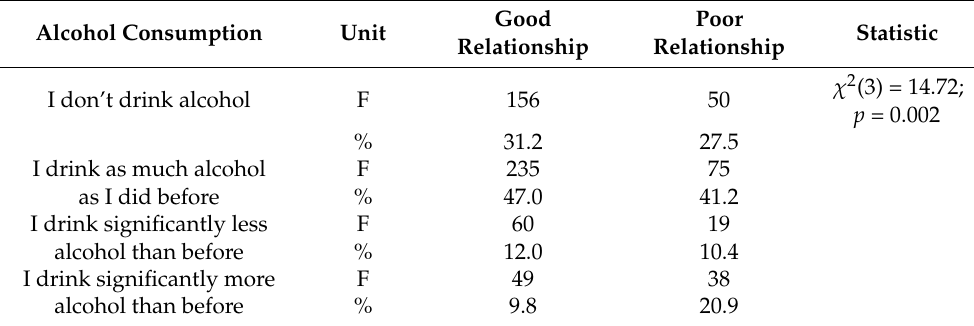
Table 3. Drinking behavior of alcoholic beverages since the initial COVID-19 restrictions in individu- als with good ( n = 500) or poor ( n = 182)